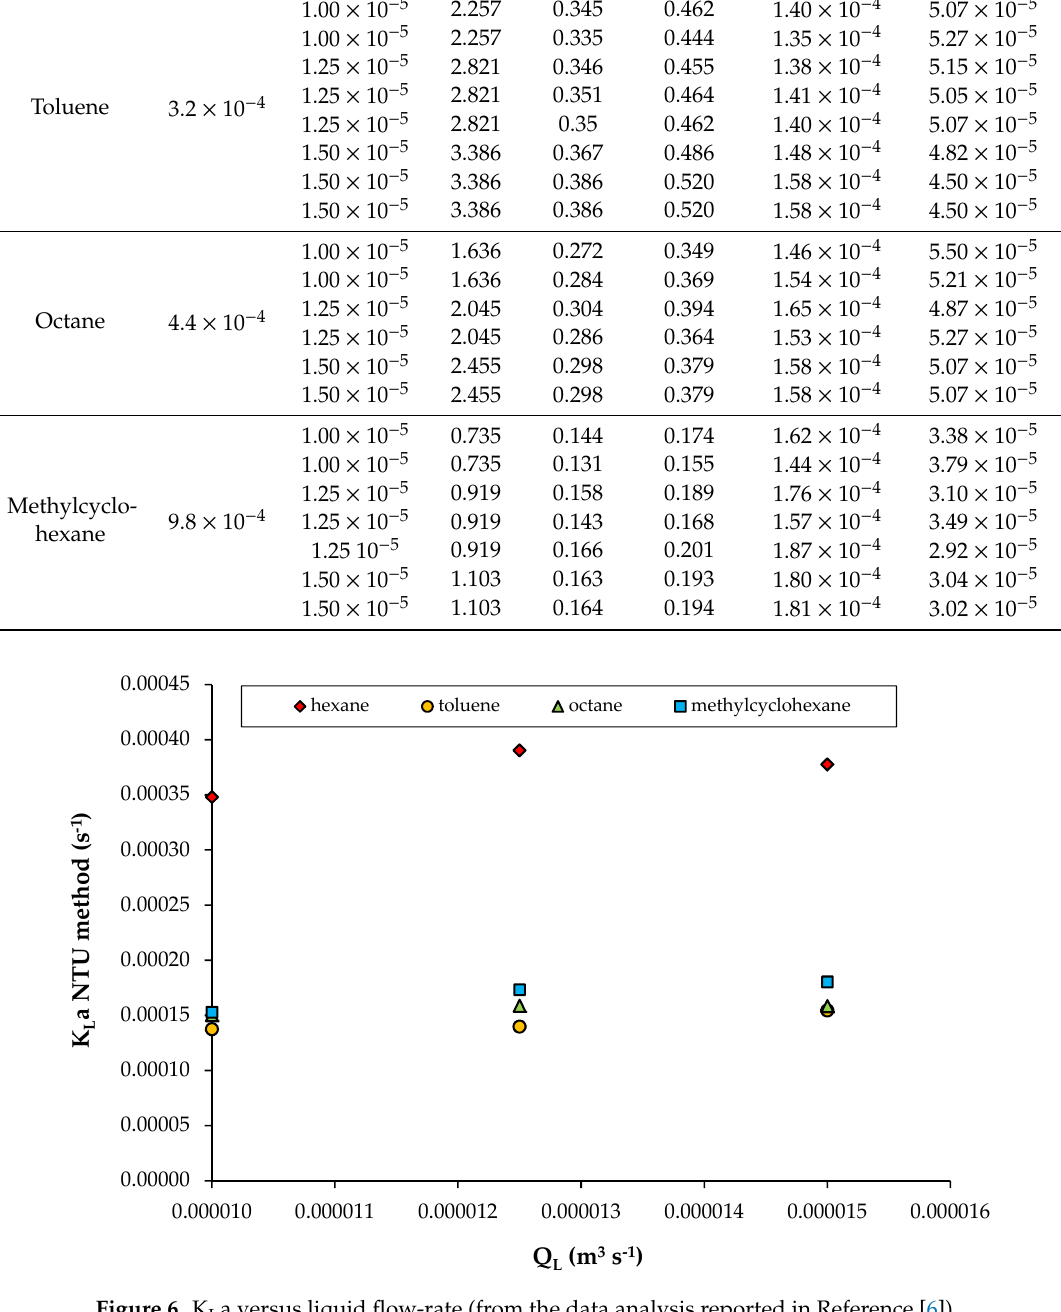
Figure 7. K L a versus Henry coefficient (from the data analysis reported in Reference [6]). Diamond: gas flow-rate = 1.0 × 10 −5 m 3 /s; circle: gas flow-rate = 1.25 × 10 −5 m 3 /s; square: gas flow-rate = 1.50 × 10 −5 m 3 /s. Table 4. K L a determination using the data reported in Bourgois et al. [6]. For all the experiments, solvent: DEHP (di-2-ethylhexyl phtalate); gas flow-rate = 1.39 × 10 −2 m 3 /s (gas EBRT = 1 s; V = 1.46 × 10 −2 m 3 ). Solute